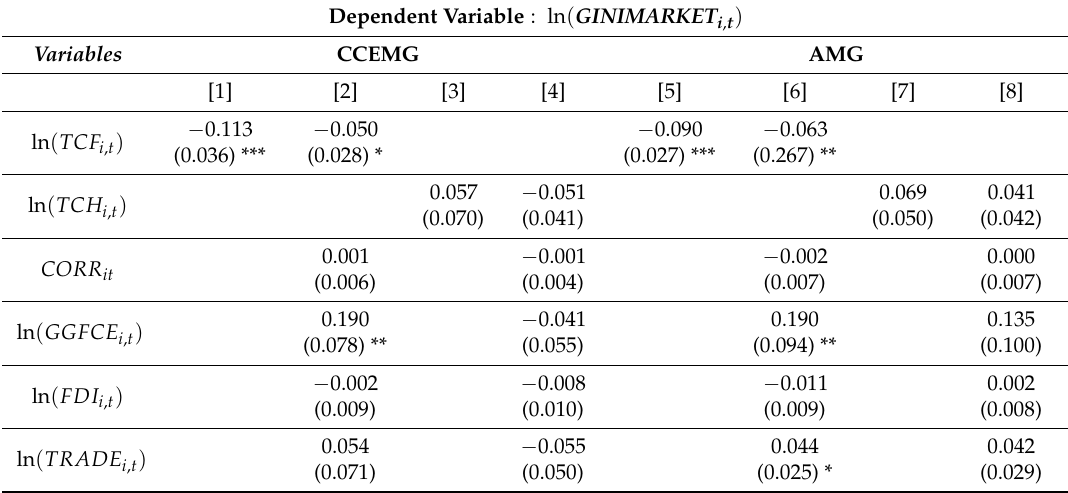
Table 5. Mean Group Type Estimations (the market Gini Coefficient and Credit